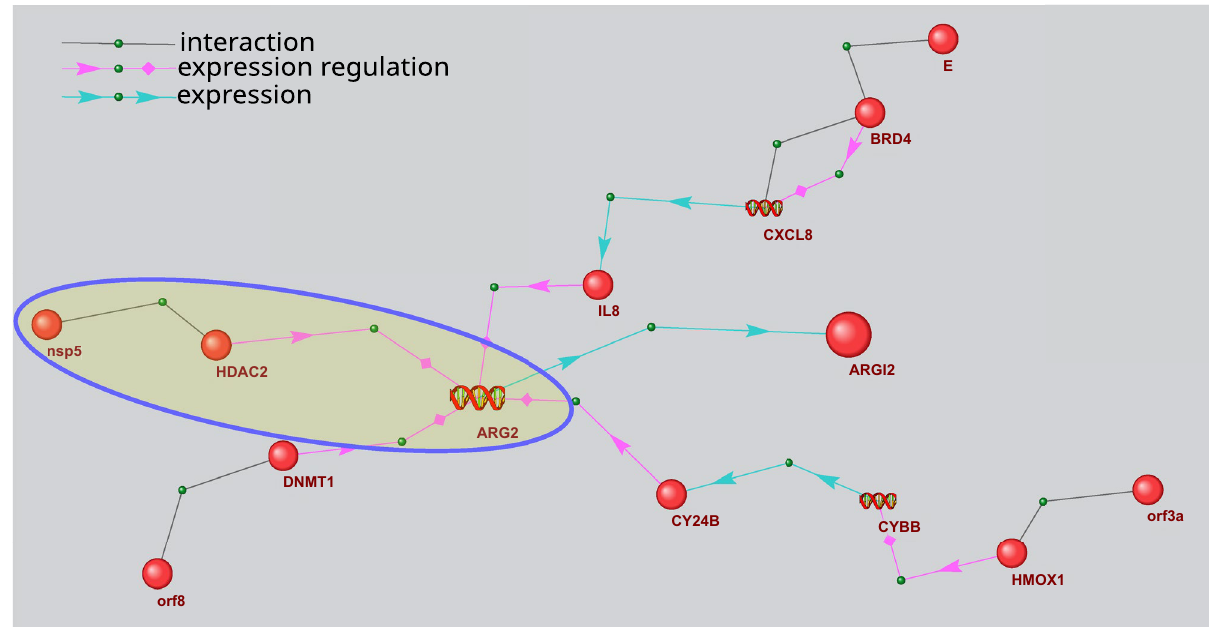
Figure 7. Pathways of arginase 2 (ARG2) expression regulation by viral proteins. The bigger ball designates ARG2, while the smaller ones designate other proteins. Spirals designate the genes. The pathways discussed in the text are